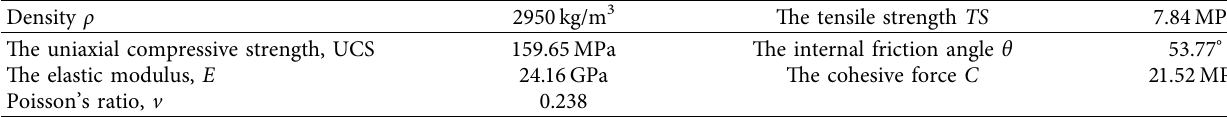
Table 1: The basic mechanical properties of dolomite.